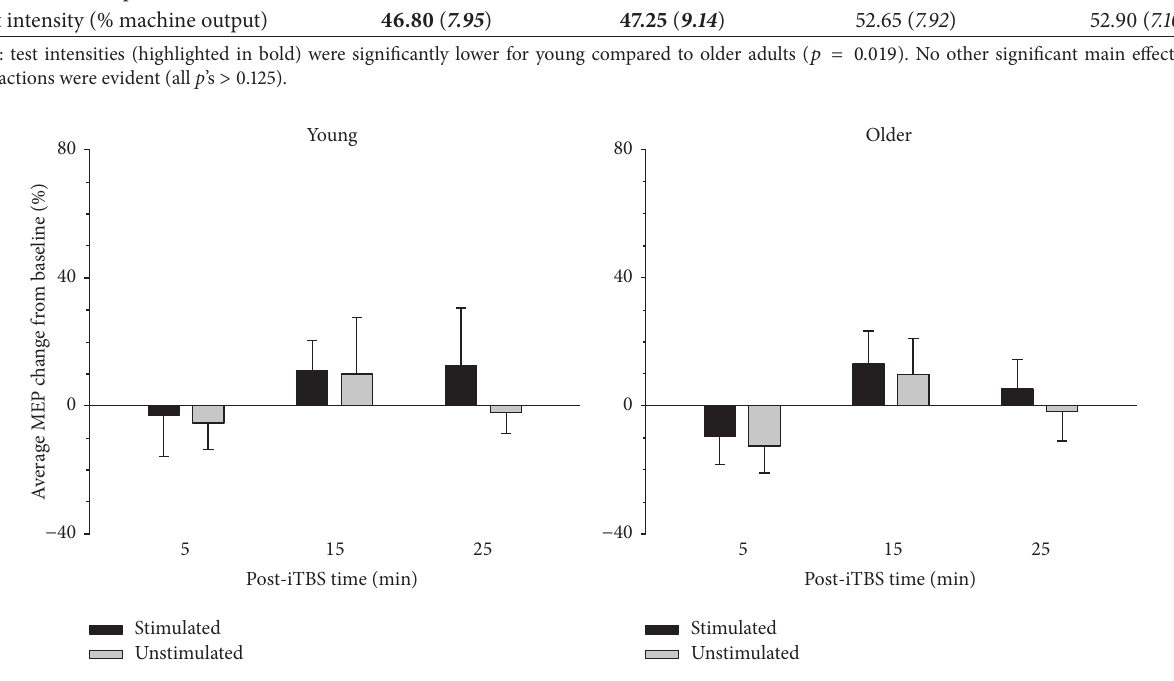
Figure 3: Average normalised MEP change following iTBS. Average MEP change relative to each individual’s baseline varied significantly across post-iTBS measures with the largest difference evident between the 5- and 15-minute time points. This pattern was comparable between young and older adults and between the hemisphere receiving iTBS (stimulated) and the hemisphere not receiving iTBS (unstimulated). Error bars denote SEM